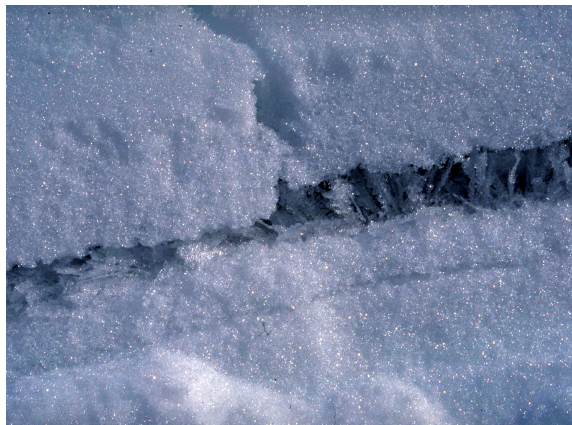
Figure 1. Weak layer of buried surface hoar. Left of the vertical slab fracture the weak layer has collapsed, whereas on the right-hand side the porous weak layer is still intact. Reprinted from the Journal of Glaciology (Jamieson and Schweizer, 2000) with permission of the International Glaciological